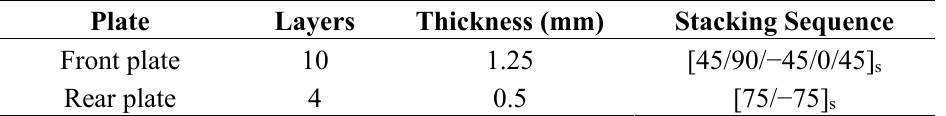
Table 1. Stacking sequences and thickness of the front and rear plates.